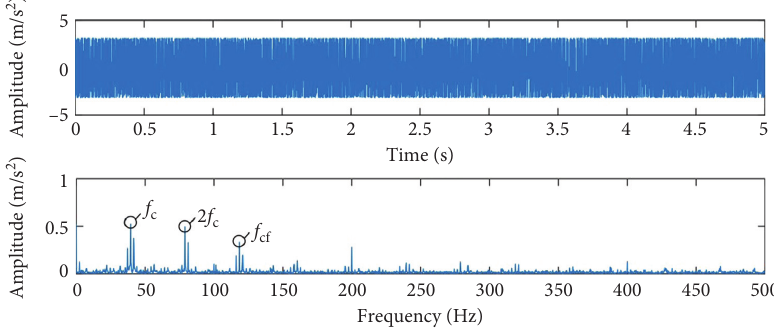
Figure 9: Signal processed by SR.